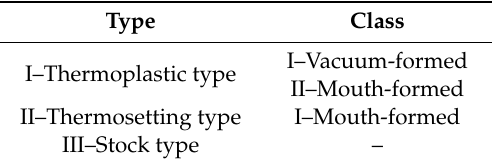
Table 1. Classification of mouthguards according to ASTM F697-16 [13].